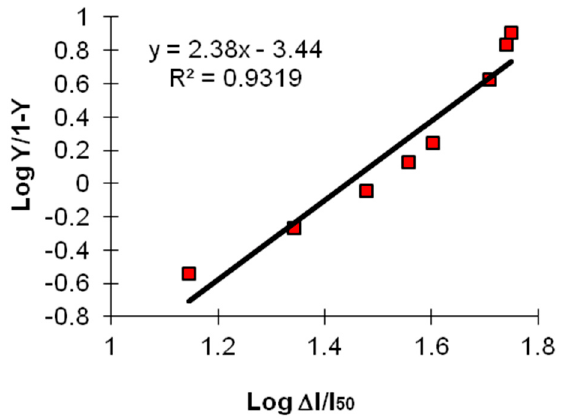
Figure 3. Hill’s coefficient “x” (in decane, for ethanol determination with catalase enzyme) using equation Log (Y/1 − Y) = x log ( ∆ I/I 50 ); in all cases, Relative Standard Deviation % (RSD%) ≤ 5.5. Concerning the (x) slope, as the slope value is greater than 1, higher is the sensitivity of biosensor.